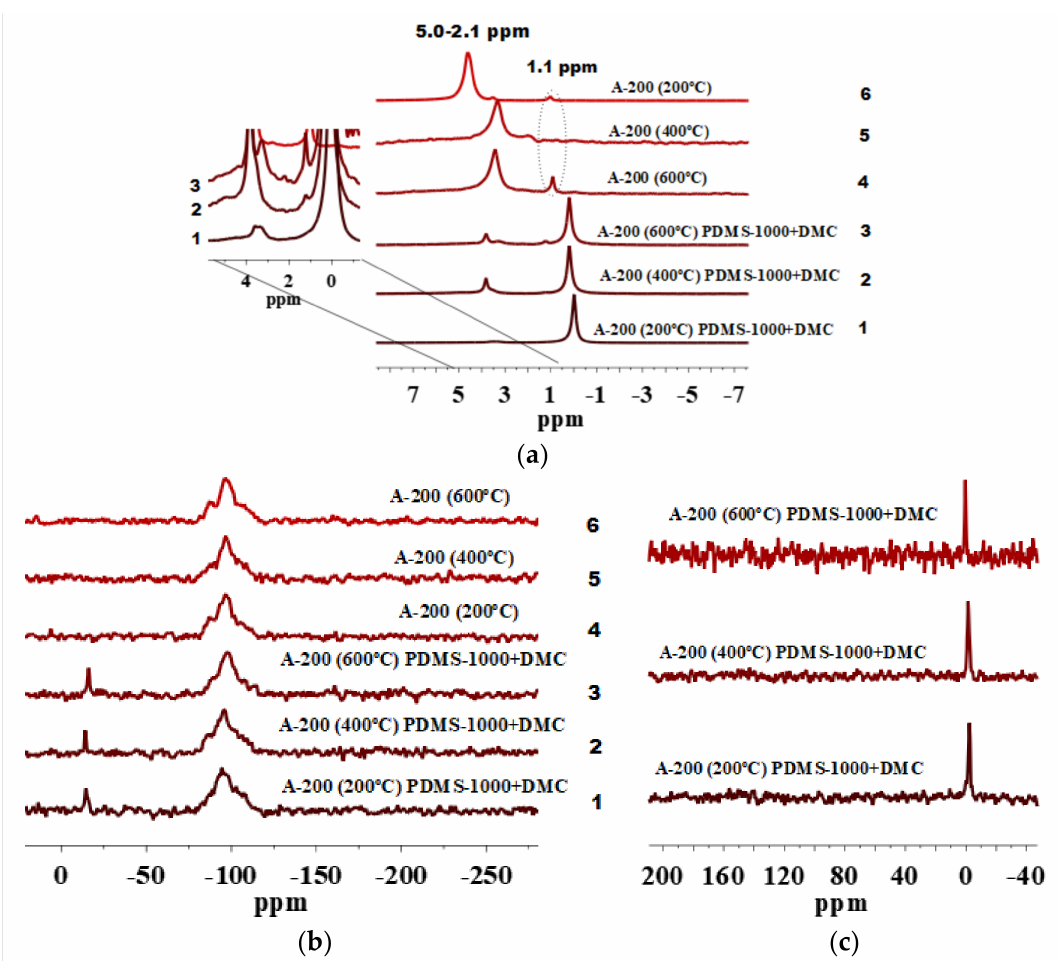
Figure 7. ( a ) 1 H MAS NMR, ( b ) 29 Si NMR, and ( c ) 13 C CP/MAS NMR spectra of A-200 preheated at 200, 400, and 600 ◦ C and modified by